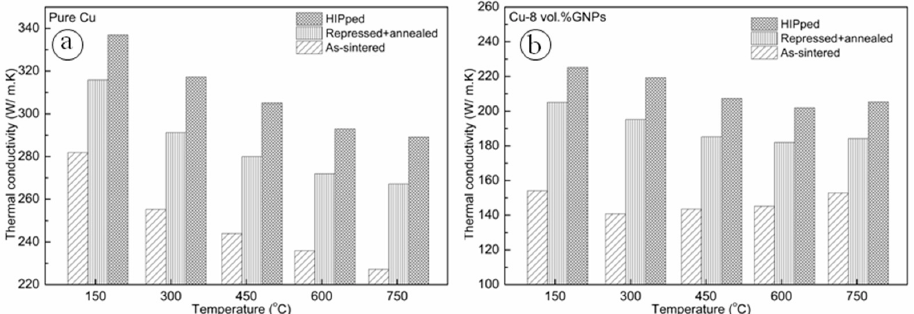
Figure 13. conductivity of ( a ) pure Cu, ( b ) Cu-8 vol % GNPs after sintering, repressing-annealing and HIPing processes [142], Reproduced from [142], with permission from Springer Nature, 2018.